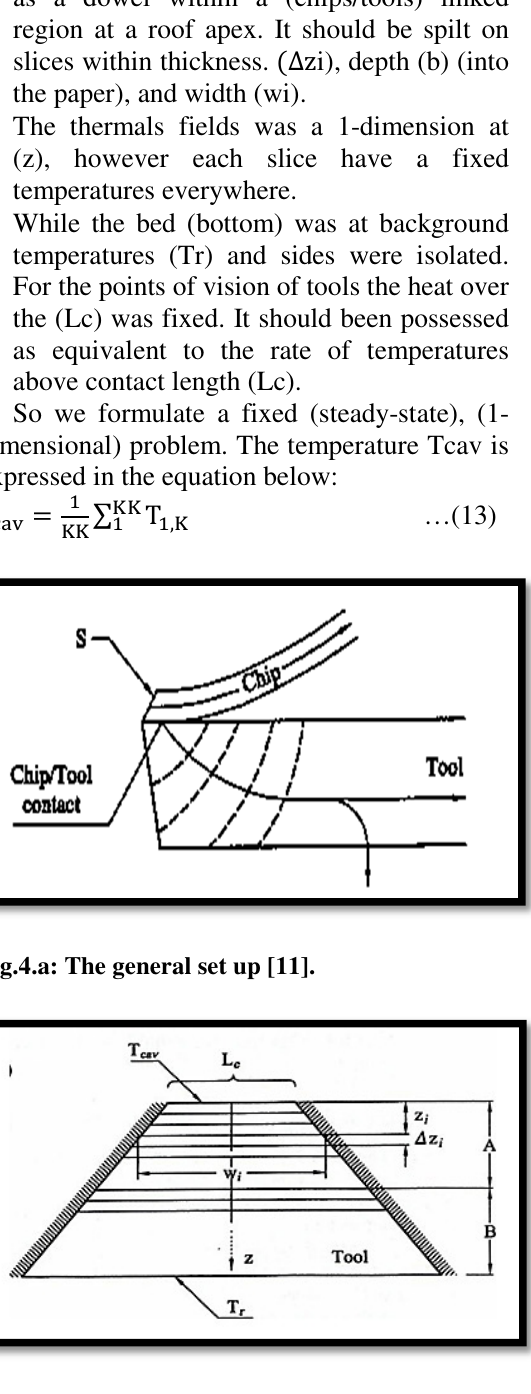
Fig. 4.b. The finite-difference formulation Diagram of the tool [11].